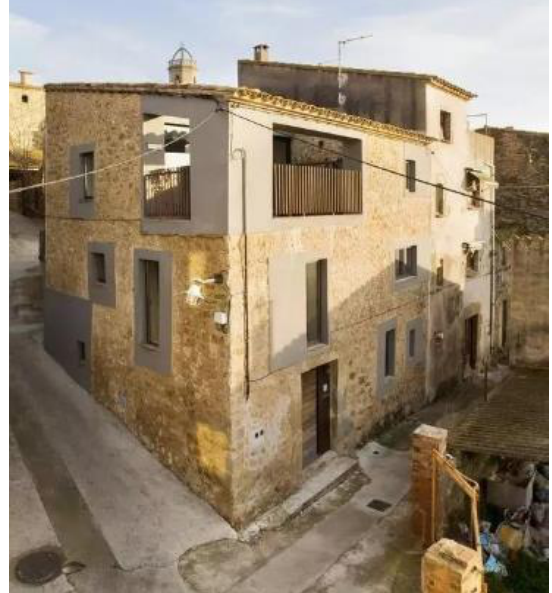
Figure 26. Repair construction (source: [52]).